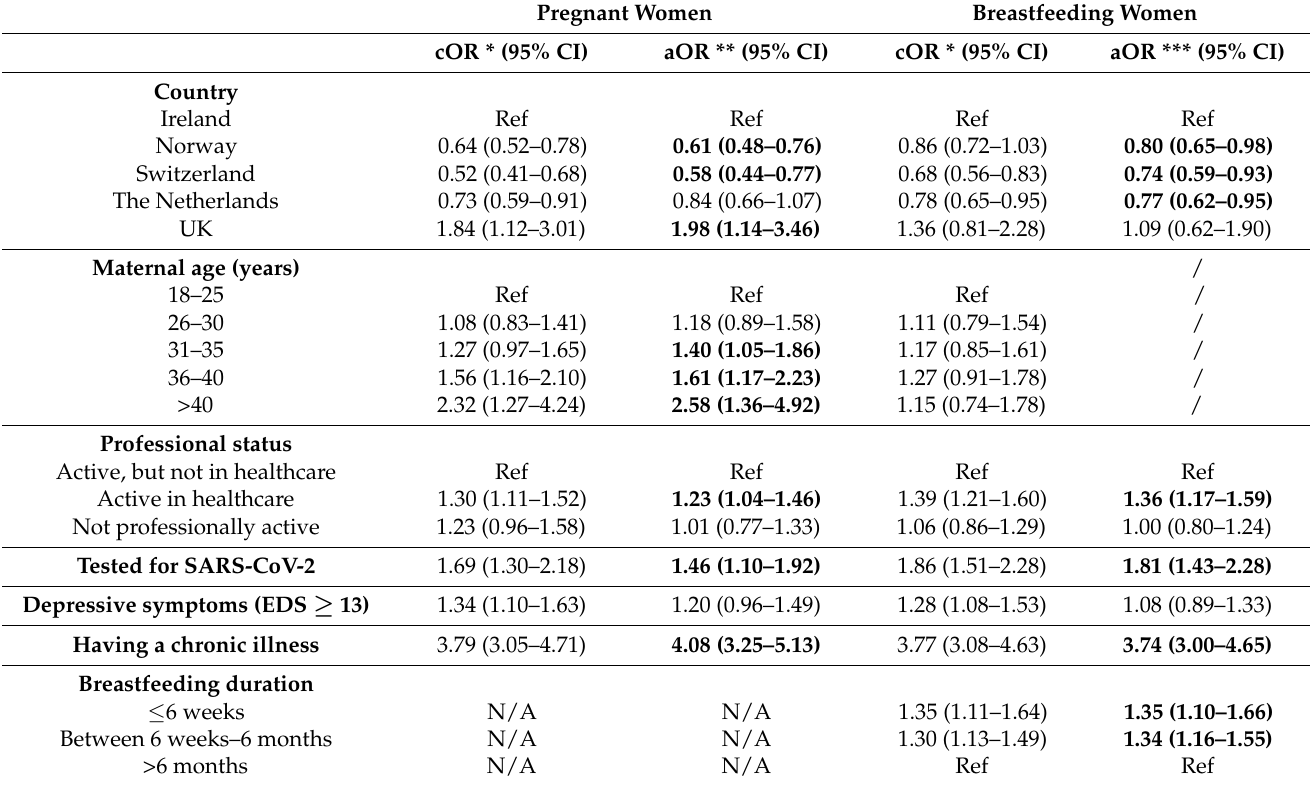
Table 3. Factors associated to medication use among pregnant and breastfeeding